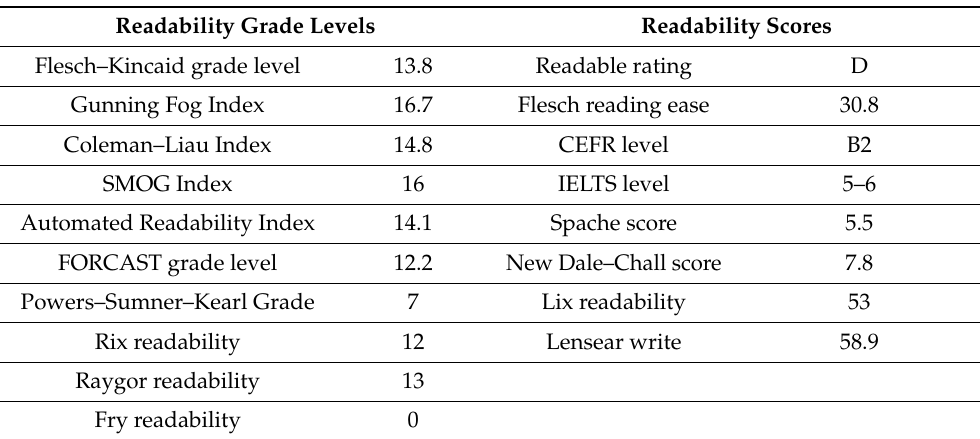
Table 6. Readability Statistics for Online Exercise Content (Source: Lumos Text Complexity